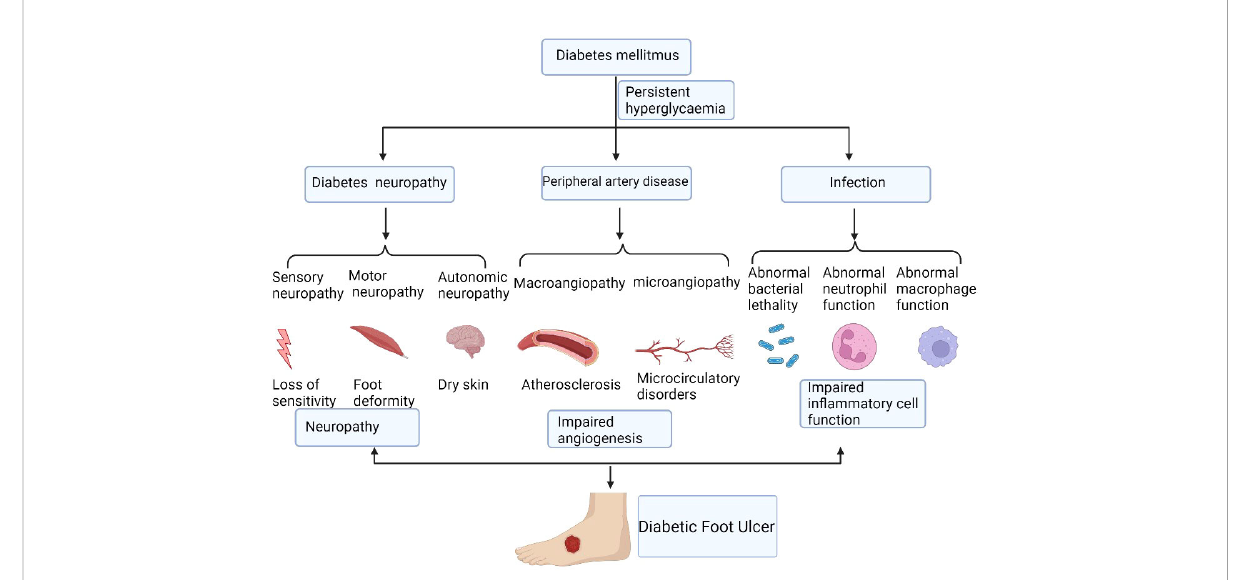
FIGURE 1 The mechanisms of diabetic non-healing wound development. Diabetic foot ulcers are caused by a number of factors that ultimately lead to chronic wound. These factors include persistent hyperglycaemia, diabetic neuropathy, peripheral artery disease, and local infection, which cause the impairment of angiogenesis and in fl ammatory cell function. Figure created using BioRender